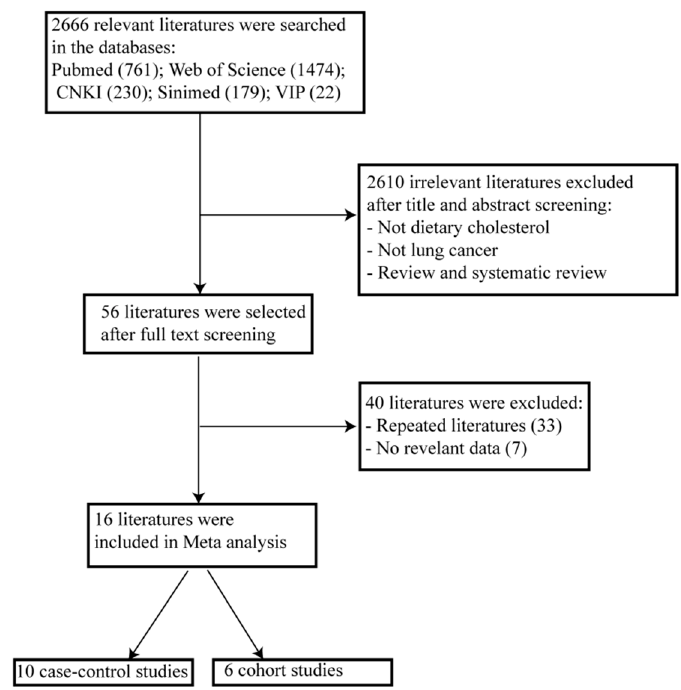
Figure 1. Flow diagram of the literature selection.